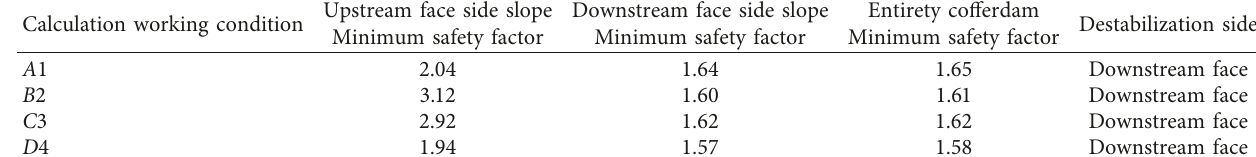
Table 3: Factor of safety (FOS) of cofferdam stability for all load conditions.